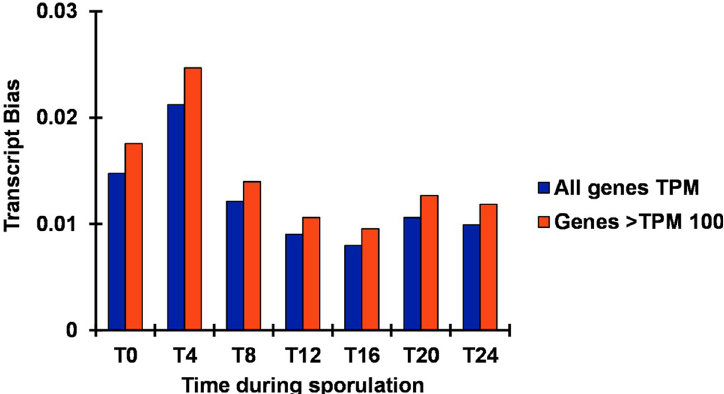
Fig 2. Transcript bias during oocyst sporulation. The bias in transcription (when a subset of genes most disproportionately contribute to transcripts) is greatest earlier in sporulation and peaks at hour 4 (T4). Parallel temporal patterns in transcriptional bias hold whether the analysis is performed on all genes (blue) or restricted to those each contributing at least 100 transcripts per million (TPM > 100) (orange). The mean among the biological replicates is shown for each